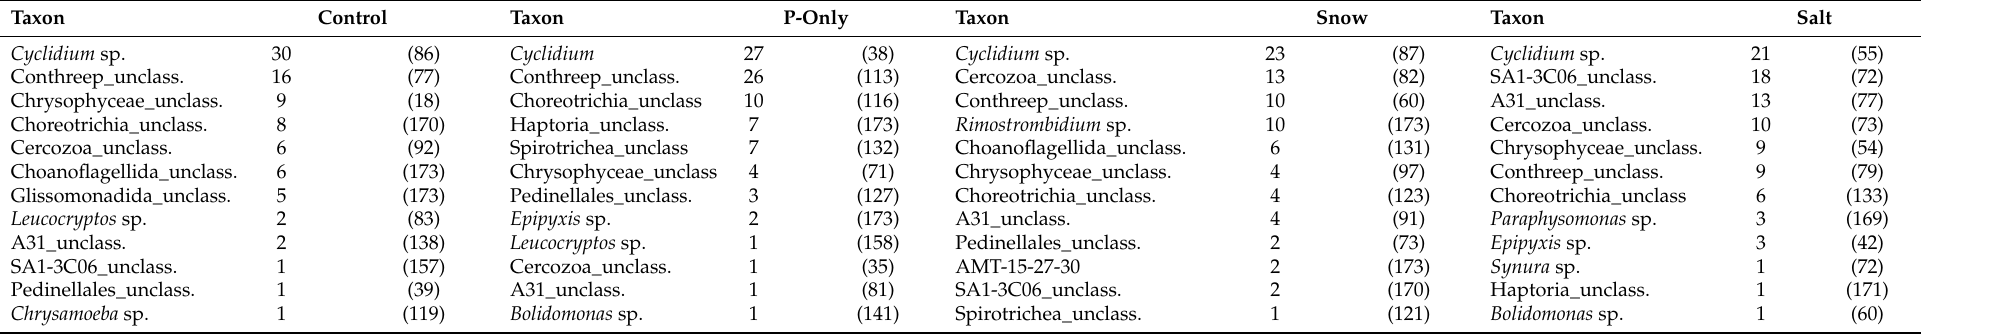
Table 4. The relative abundance (% of total reads) of the twelve most abundant eukaryote taxa (resolved to genus where possible) within each treatment. Each value is the mean of triplicate incubations (SD as the percent mean in